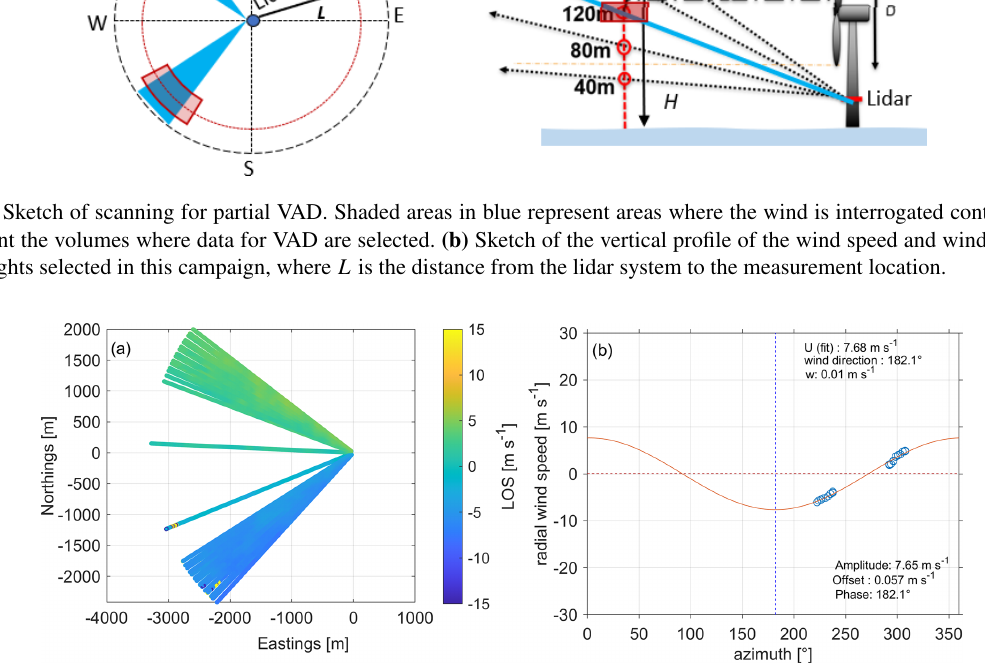
SSL indicates a different bias in each axis of the inclinome- ter, namely tilt bias = − 0 . 05 ◦ and roll bias = + 0 . 05 ◦ . A